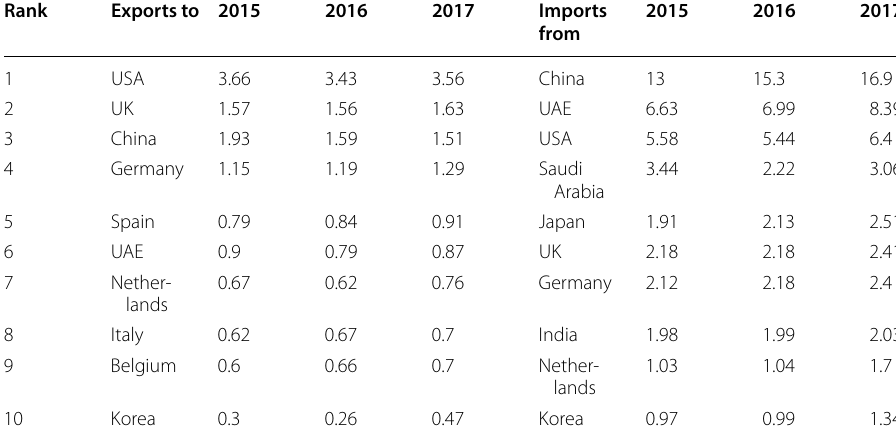
Table 1 Pakistan major export and import markets (US$ billion) Source: World Bank data